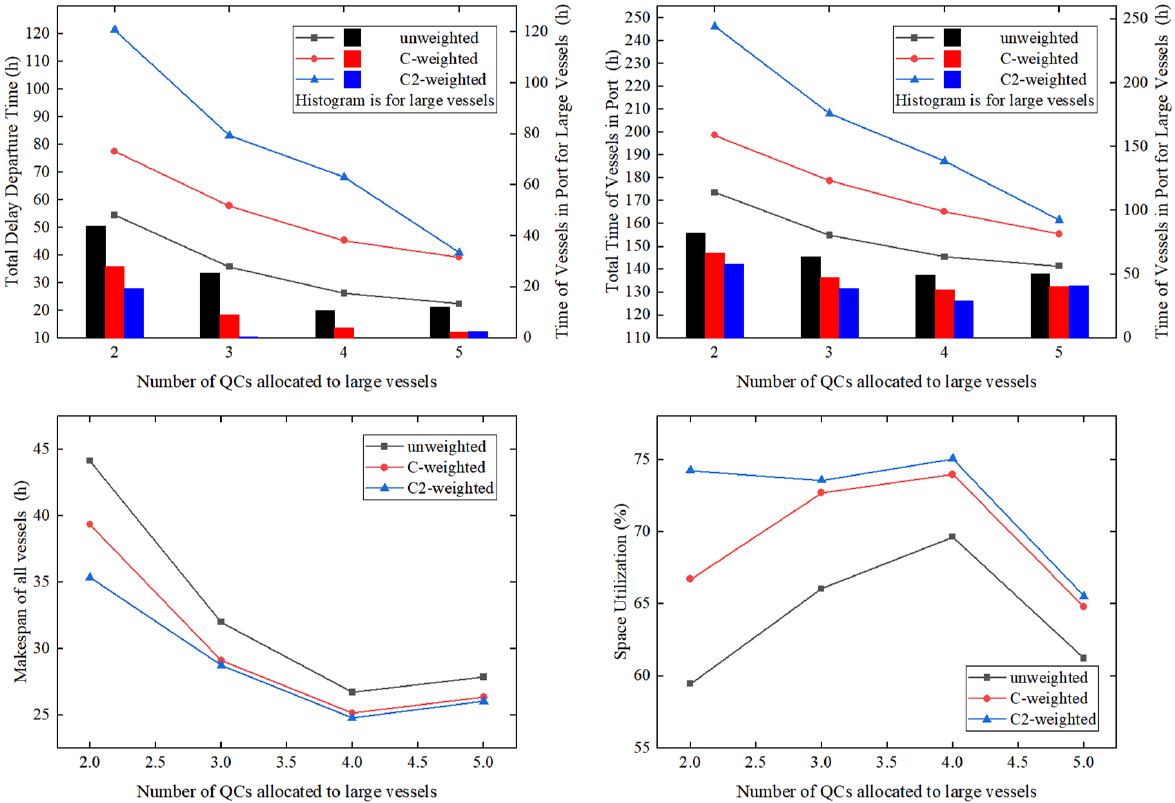
Figure 6. Scheduling results of different numbers of QC allocated to large vessels.